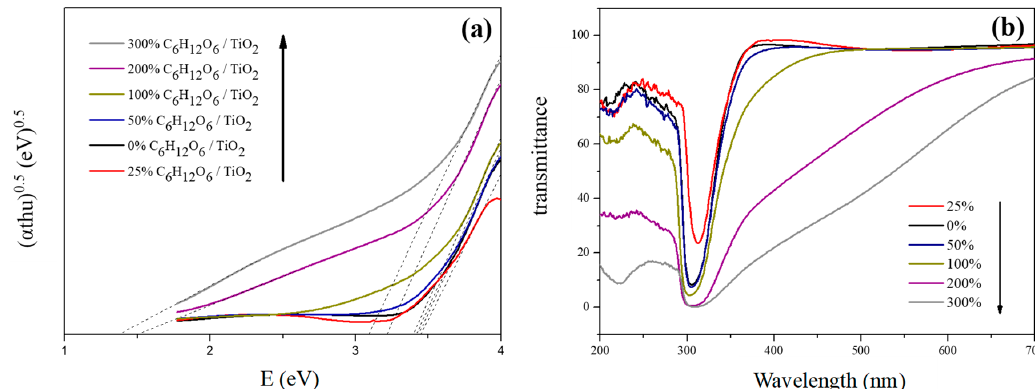
Figure 8. ( a ) UV-visible transform spectra (Tauc plots) and ( b ) transmittance spectra of various C–TiO 2 films.